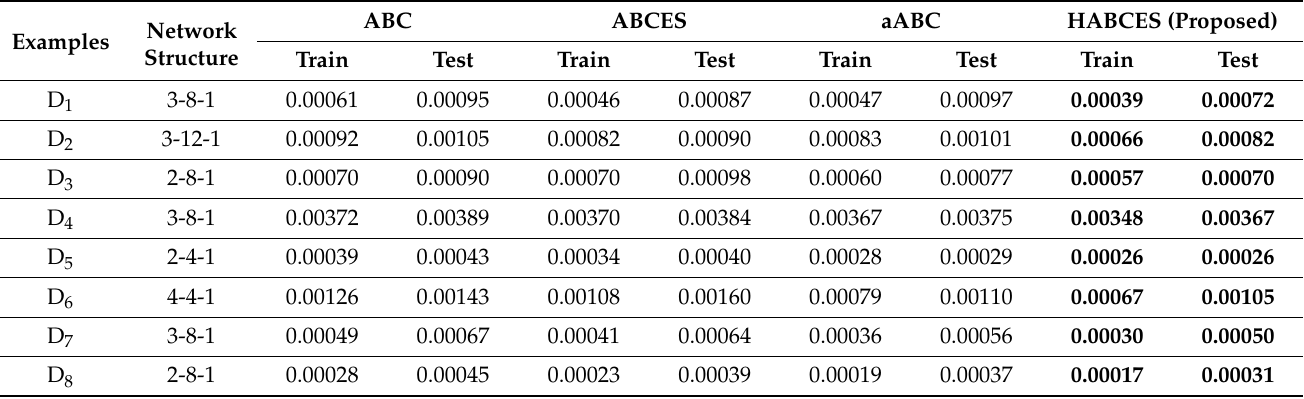
Table 11. Comparison of the results of the ABC, aABC, ABCES and HABCES algorithms for nonlinear dynamic system